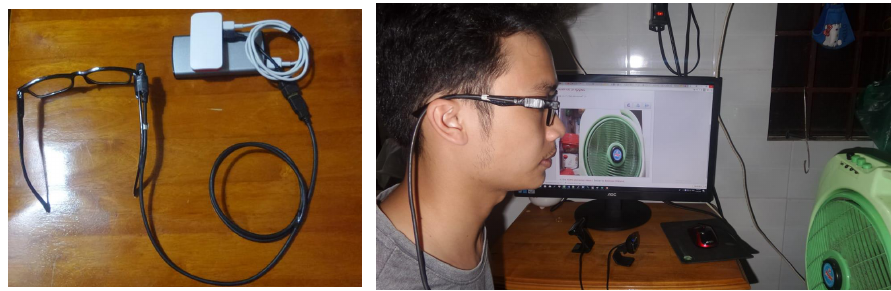
Figure 2. The smart glasses with